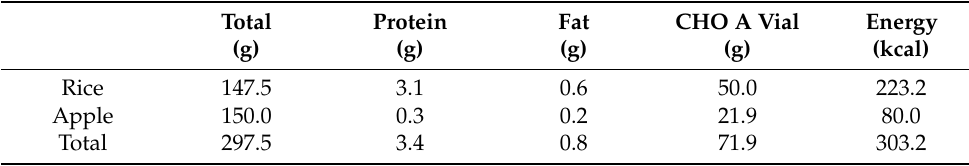
Table 1. Nutritional components and test food